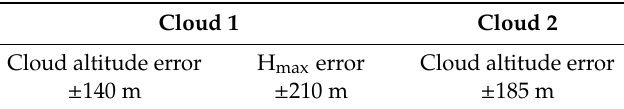
Table 2. Plume height error